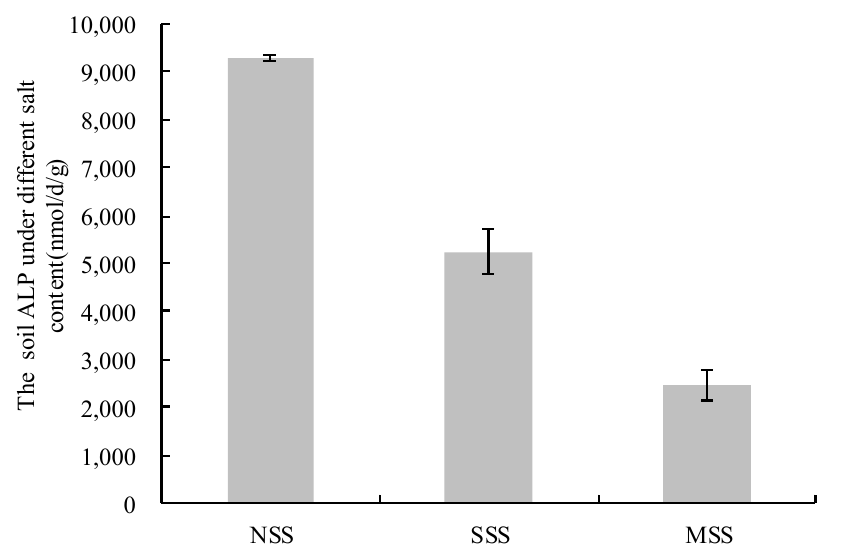
Figure 7. Soil alkaline phosphatase activity under different soil salinity environment.